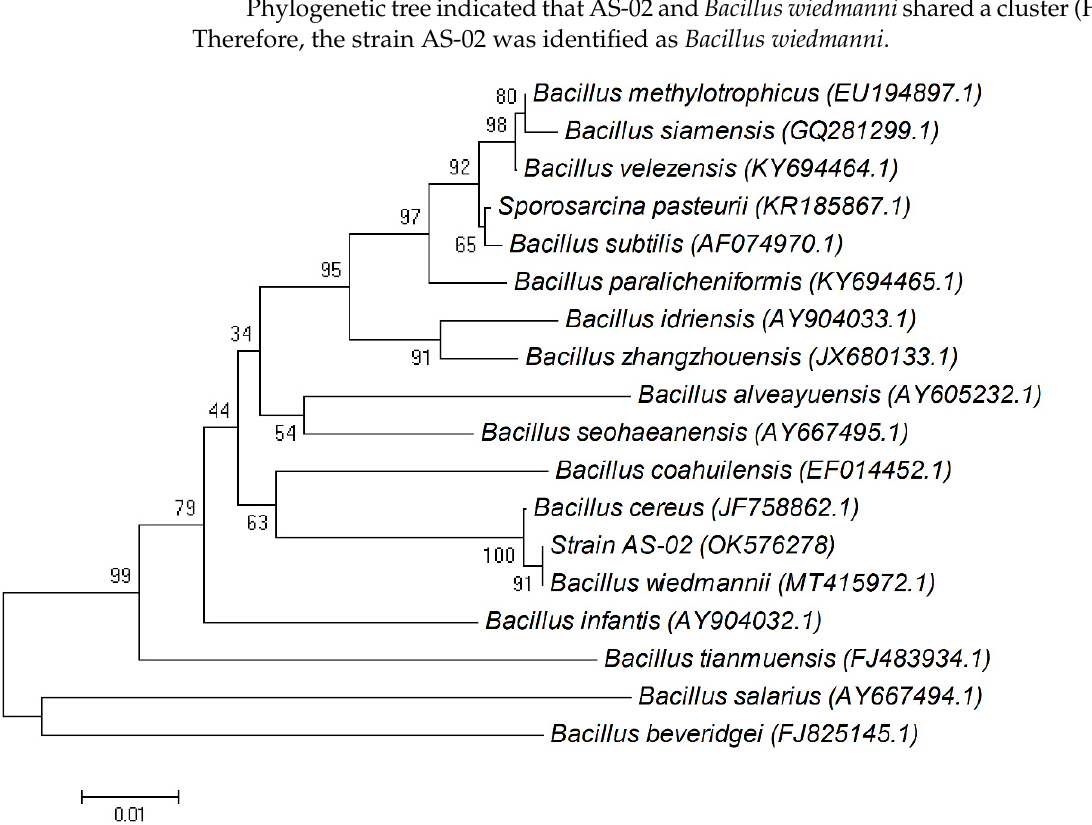
Figure 2. Phylogenetic tree on the basis of the patterns and the genetic relationship of Bacillus wiedmannii OK576278.